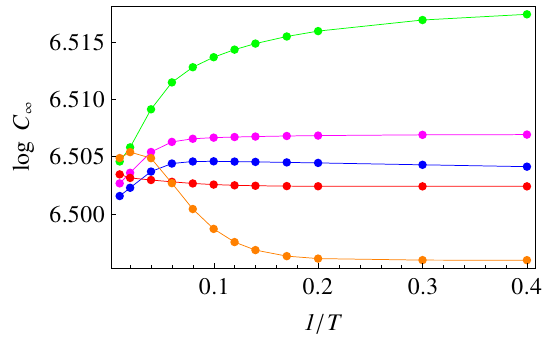
Figure 9. Temperature dependence of the asymptotic OTOC C ∞ for the inverse Henon-Heiles Hamiltonian, with ω 2 = 4 ω 2 = − 1 , and perturbation strength (cid:15) = 0 , 0 . 1 , 0 . 5 , 0 . 9 , 1 . 5 (blue, green, x y magenta, red, orange). The curves are more or less flat and without a clear trend, as the scrambling is rooted in local instability, not